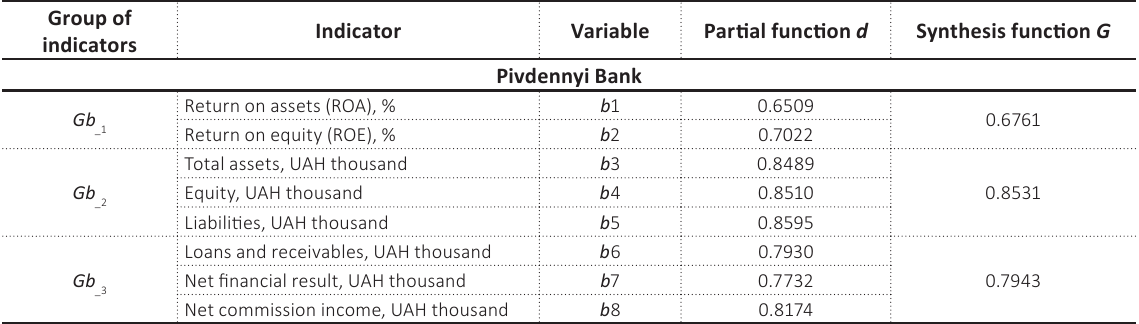
Table 4. Description of Pivdennyi Bank’s indicators as of January 1, 2021 Group of Indicator Variable Partial function d indicators